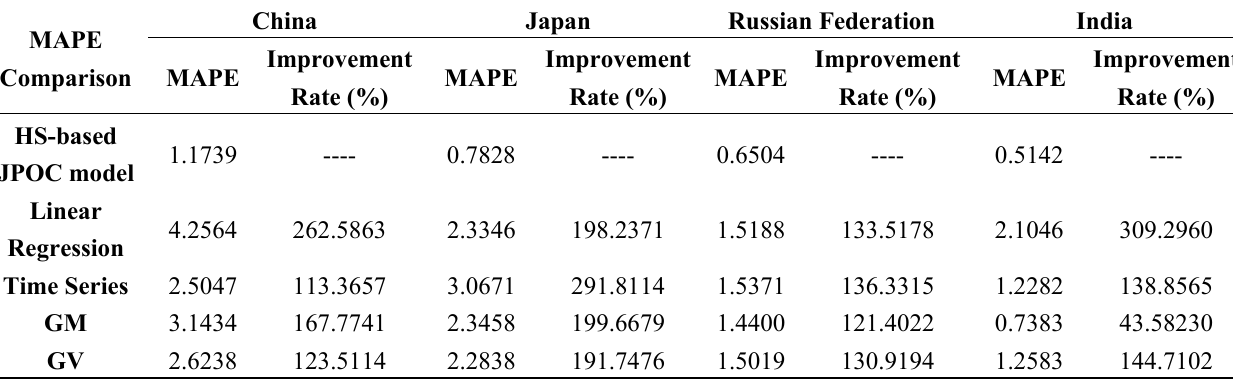
Table 7. The MAPE comparison of the HS based JPOC model and the other single models (%). MAPE